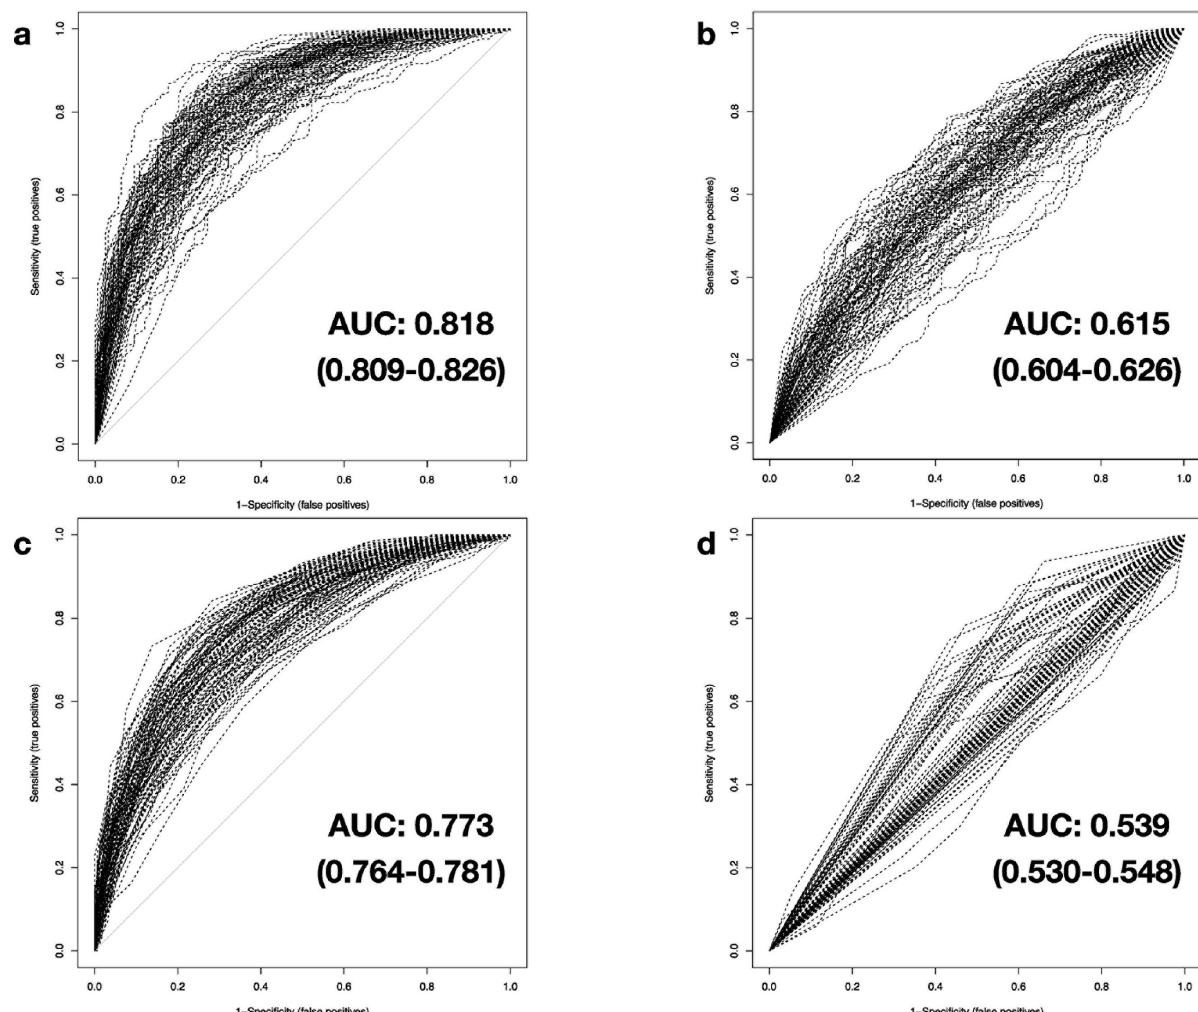
Fig 6. Comparison of classification performance with 50% simulated testing data. The results of the AUROC analysis are based on testing data with level 3 data degradation applied cumulatively to levels 1 and 2, examining simulated expression data of 2,966 genes in combination with real expression values of up to 1,483 genes for a) DNN, b) SVM, c) RF and d)